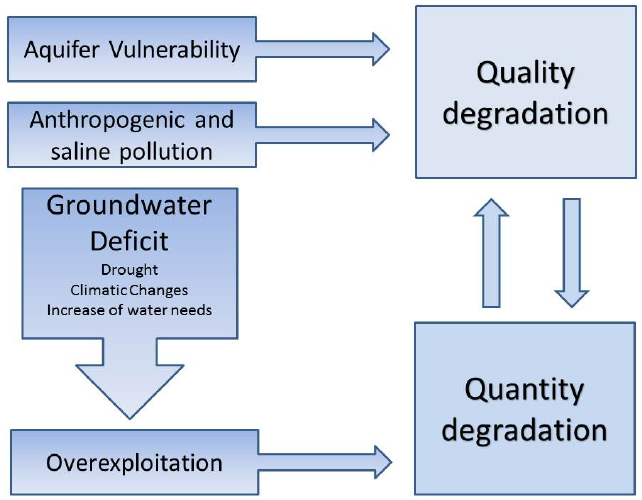
Figure 1. Schematic of the main risks of groundwater degradation.